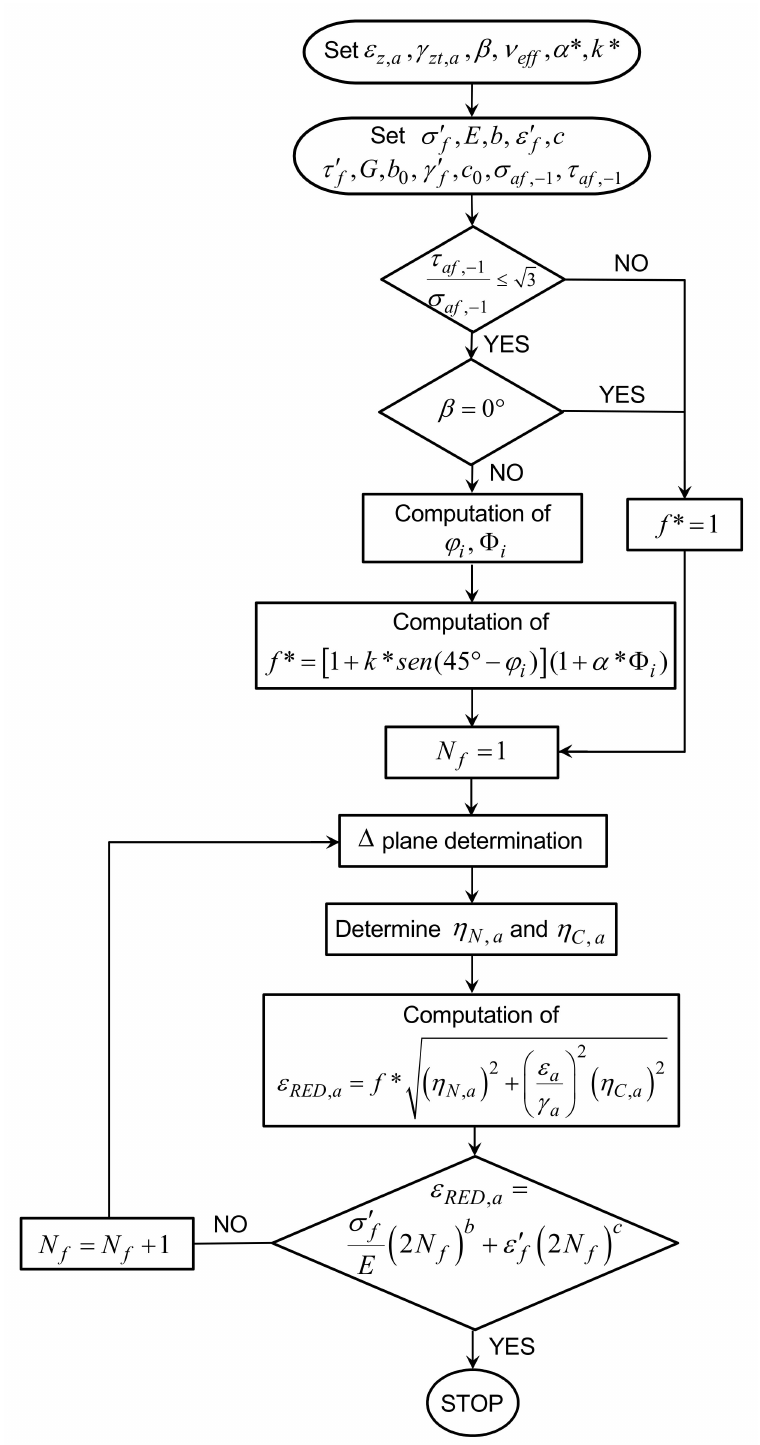
Figure 7. Flowchart of the RED